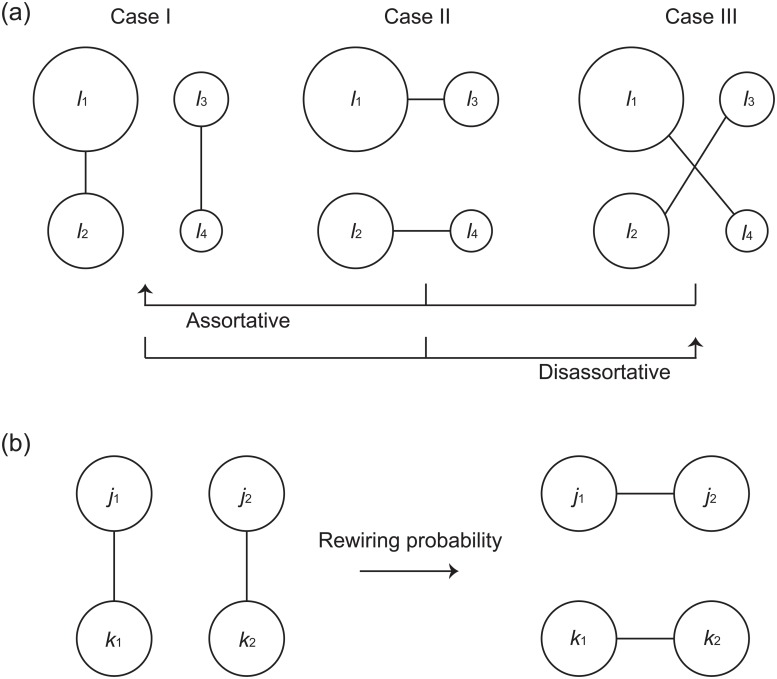
Network reshuffling methods for changing the network assortativity.(a) The greedy edge-rewiring (GER) method [36]. The remaining degrees of the two connected node pairs, (j
1, k
1) and (j
2, k
2), are sorted in the descending order and relabeled as l
1, l
2, l
3, and l
4 so that l
1 ≥ l
2 ≥ l
3 ≥ l
4. The size of the node corresponds to its remaining degree. When making the network assortative, Case I is chosen if the current state is Case II or III. When making the network disassortative, Case III is chosen if the current state is Case I or II. (b) The stochastic edge-rewiring (SER) method [8]. The acceptance probability for edge rewiring is given by min{1,E(j1,j2)E(k1,k2)E(j1,k1)E(j2,k2)} where E(j, k) is the joint probability distribution for the remaining degrees of the two nodes in the end of a randomly chosen edge.